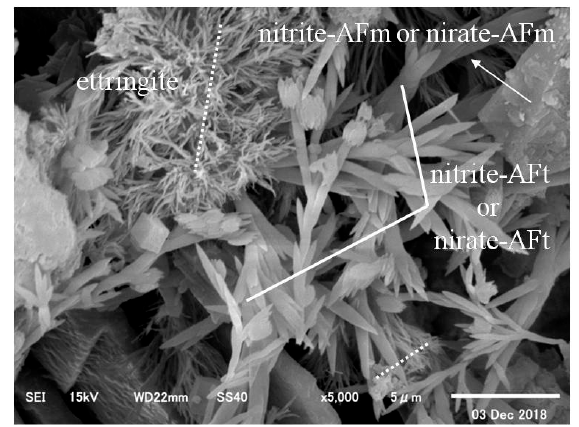
Materials 2019 , 12 , x; doi: FOR PEER REVIEW